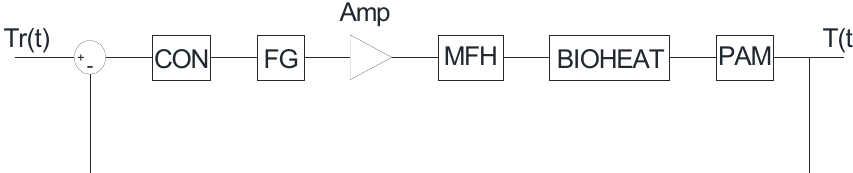
Figure 5. Block diagram of the system.